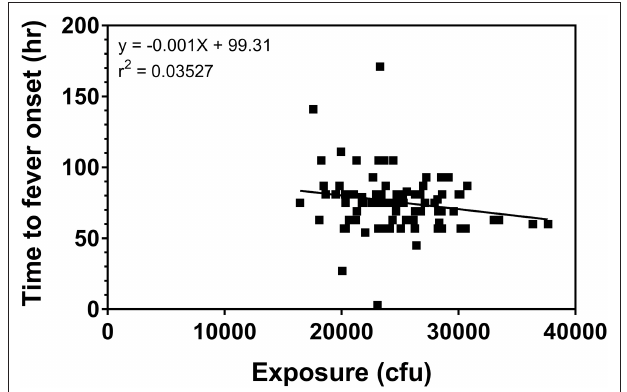
FIGURE 2 | Relationship of challenge dose to time of fever onset. Time to fever onset is calculated for each subject from temperature listings (as described in the Methods) as the first time point in which the subject exhibited 2 consecutive readings ≥ 100 ◦ F. The data represent the calculated exposure (as described in the methods) to F. tularensis Schu S4 in those subjects exposed to a target exposure = 25,000